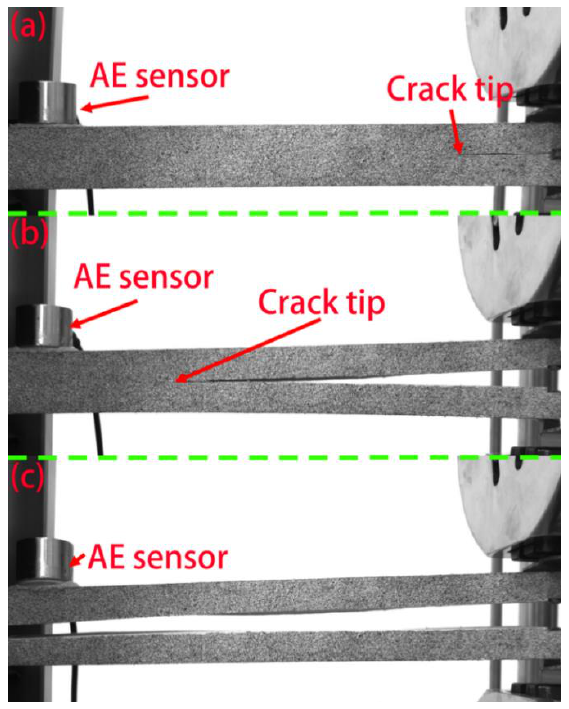
Figure 13. Distance between the AE sensor and crack tip.